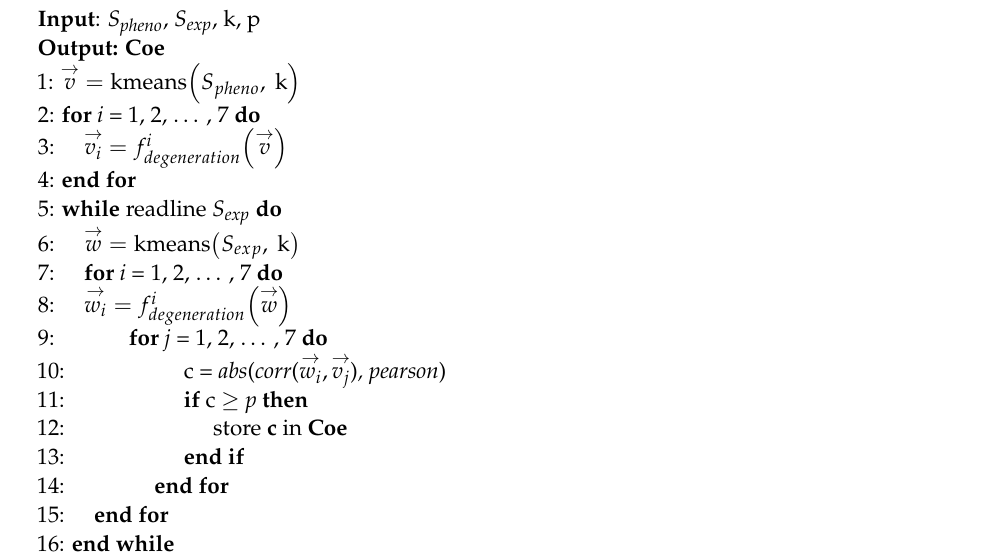
Algorithm 1: Cluster-Based Correlation Coefficient